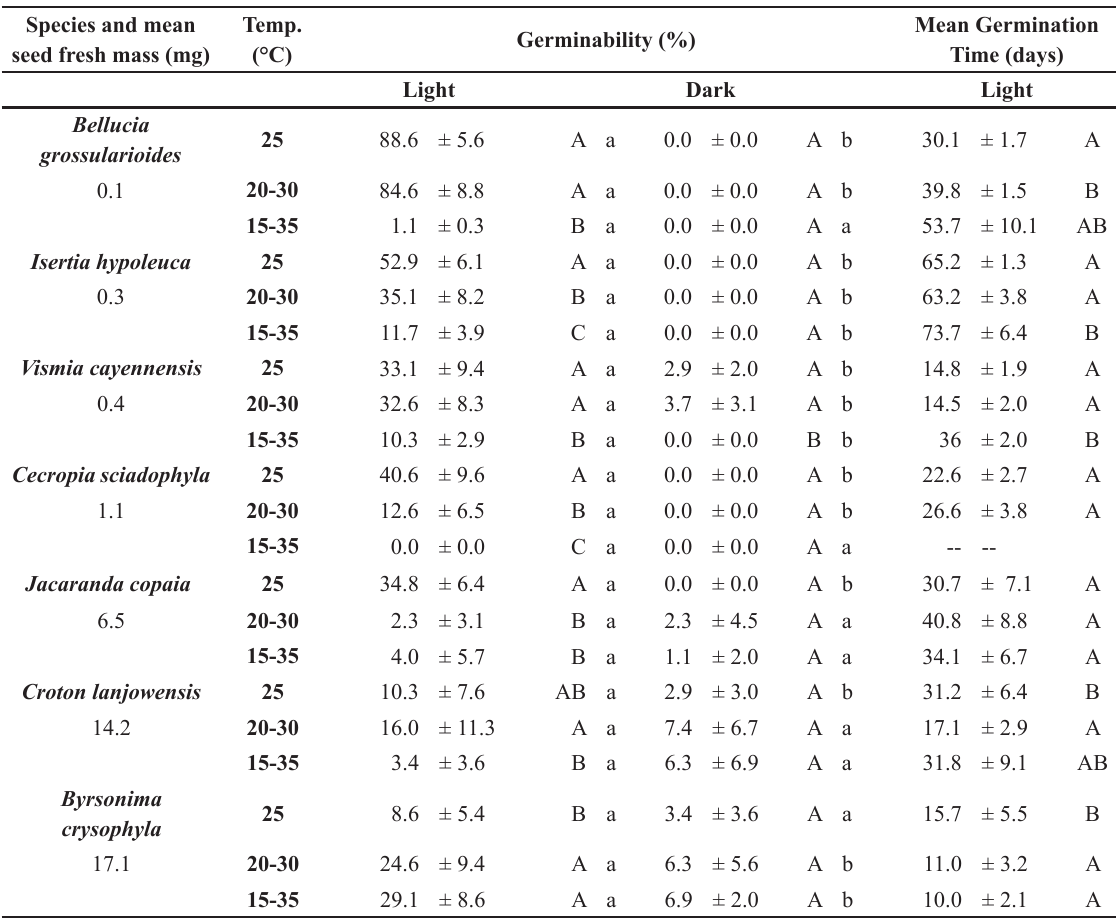
Germinability and mean germination time in light (12-hour photoperiod) and in darkness condition (mean ± standard deviation) under three temperature conditions (25 °C or 12-12 h alternating temperatures of 20-30 °C and 15-35 °C) of seven pioneer